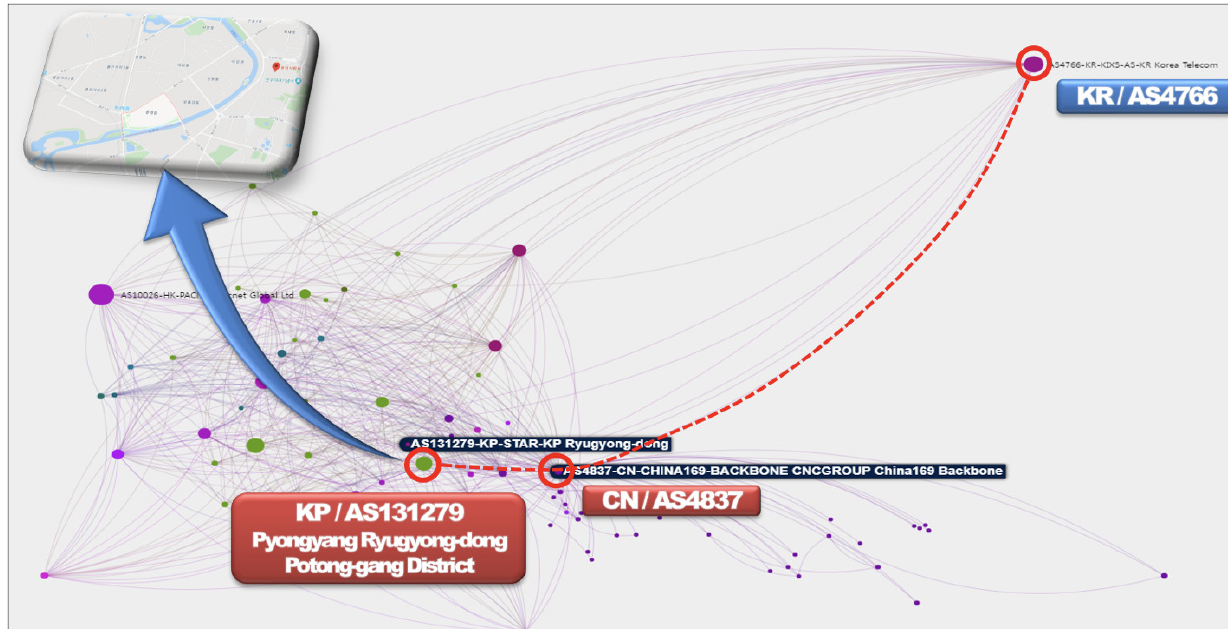
Figure 10. Visualization of North Korean network routes based on BGP archive data.